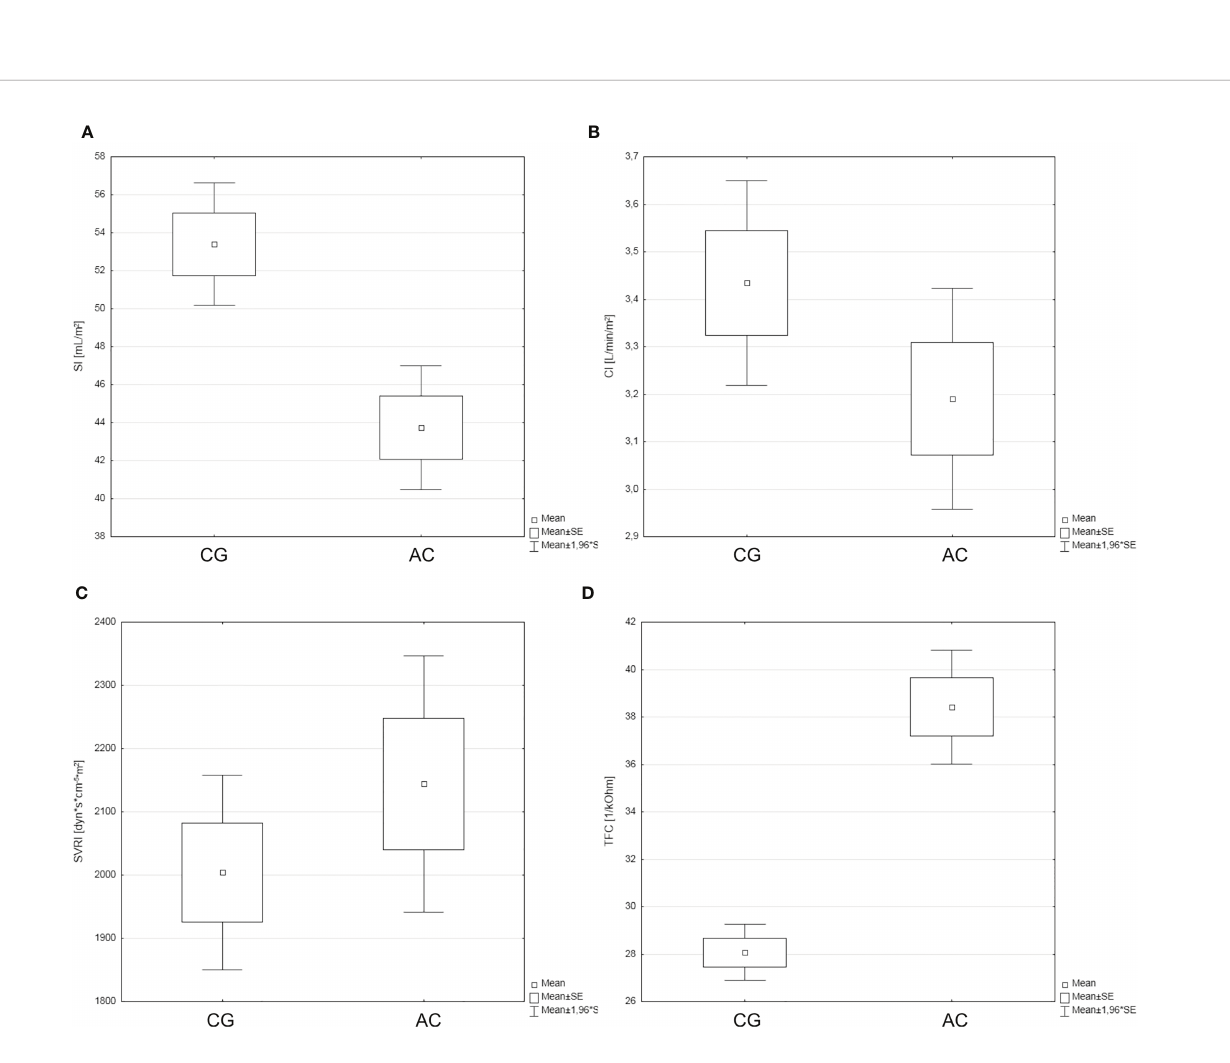
FIGURE 1 | The hemodynamic pro fi les of the study groups [control group (CG) and acromegaly (AC) group] with a particular focus on SI (A) , CI (B) , SVRI (C) , and TFC (D)